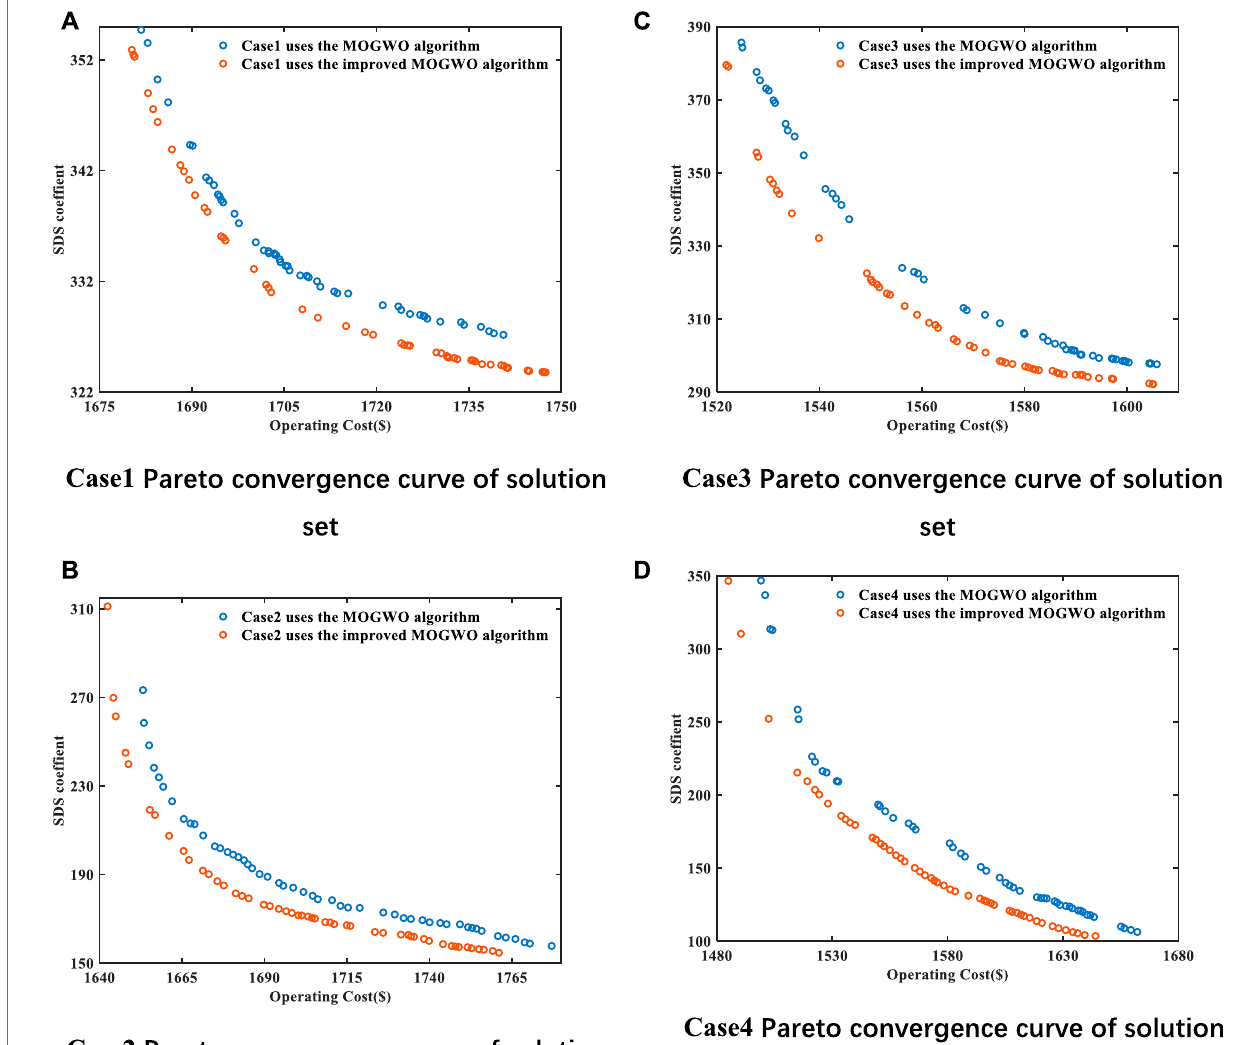
FIGURE 3 | Convergence curves of Pareto solution sets in four scenarios. (A) Case1 Pareto convergence curve of solution set. (B) Case2 Pareto convergence curve of solution set. (C) Case3 Pareto convergence curve of solution set. (D) Case4 Pareto convergence curve of solution set.